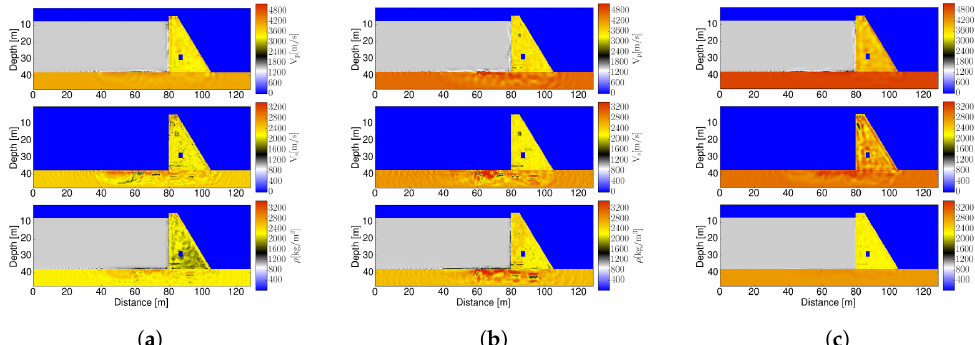
Figure 18. Cyclic multi-frequency inversion anomaly identification considering certain difference in dam as-built material properties in the starting model having additionally 2% noise in the data. ( a ) − 10% difference in starting model ( b ) +2% difference in starting model ( c ) +10% difference in starting